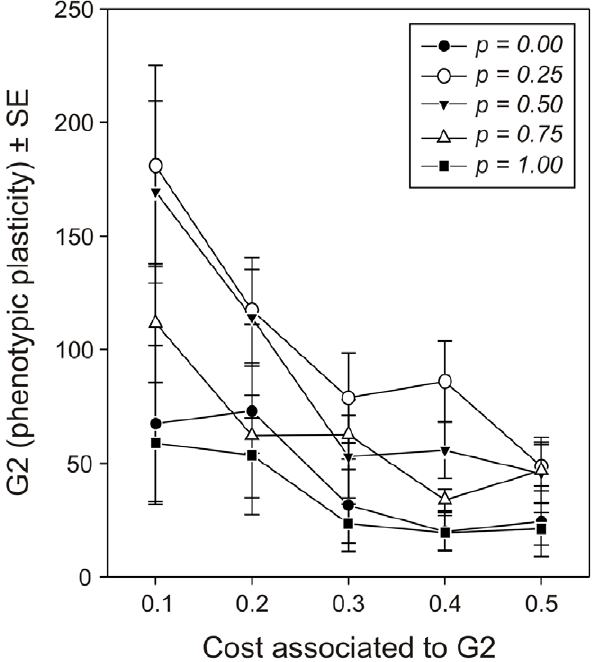
Figure 4. Effect of the cost of phenotypic plasticity and the probability for a parasitoid female to emerge on a host- containing habitat patch on the optimized values of the parameter G2. Average ( 6 SE) optimized values of G2 defining the range of phenotypic plasticity (see Figure 1) for different values of the corresponding cost and different probabilities for the parasitoid females to start their life on a habitat patch.